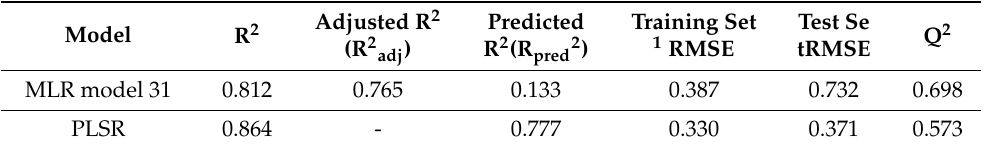
Table 1. Statistical parameters of multiple linear regression (MLR) and partial least squares regression (PLSR).